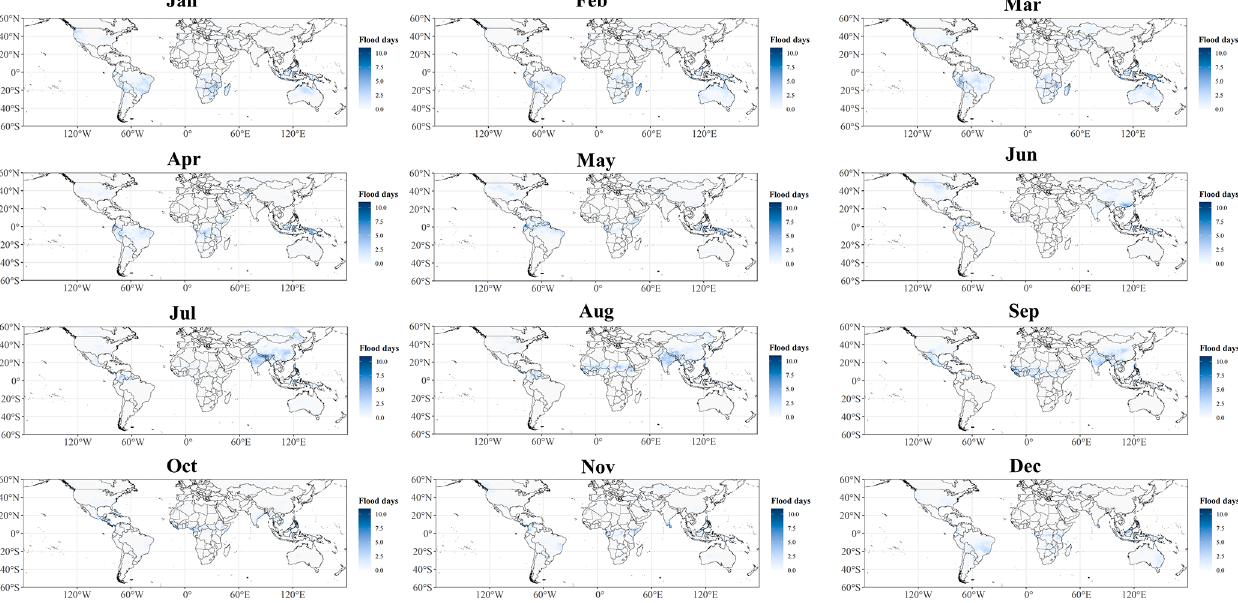
https://doi.org/10.5194/essd-15-521-2023 Earth Syst. Sci. Data, 15, 521–540,